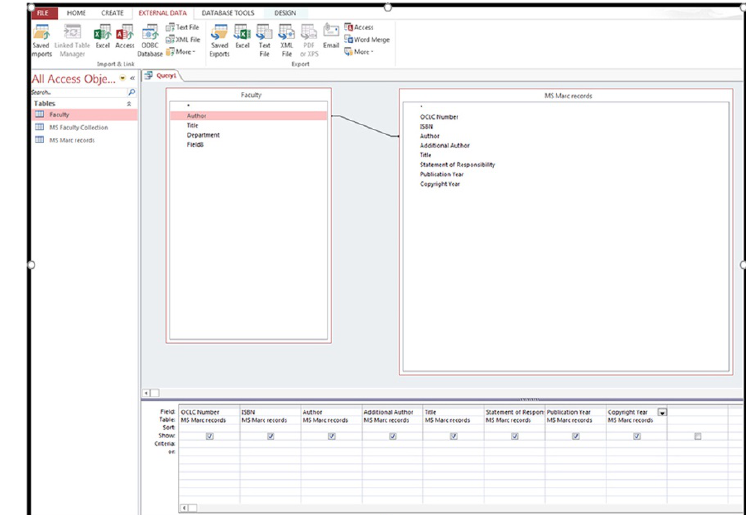
Figure 2 Microsoft Access